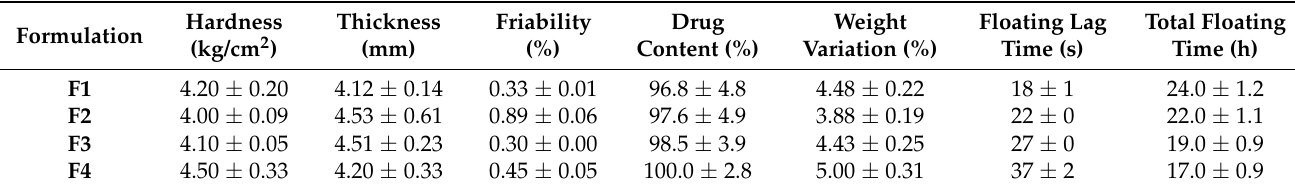
Table 3. Post-compression evaluation of nizatidine floating